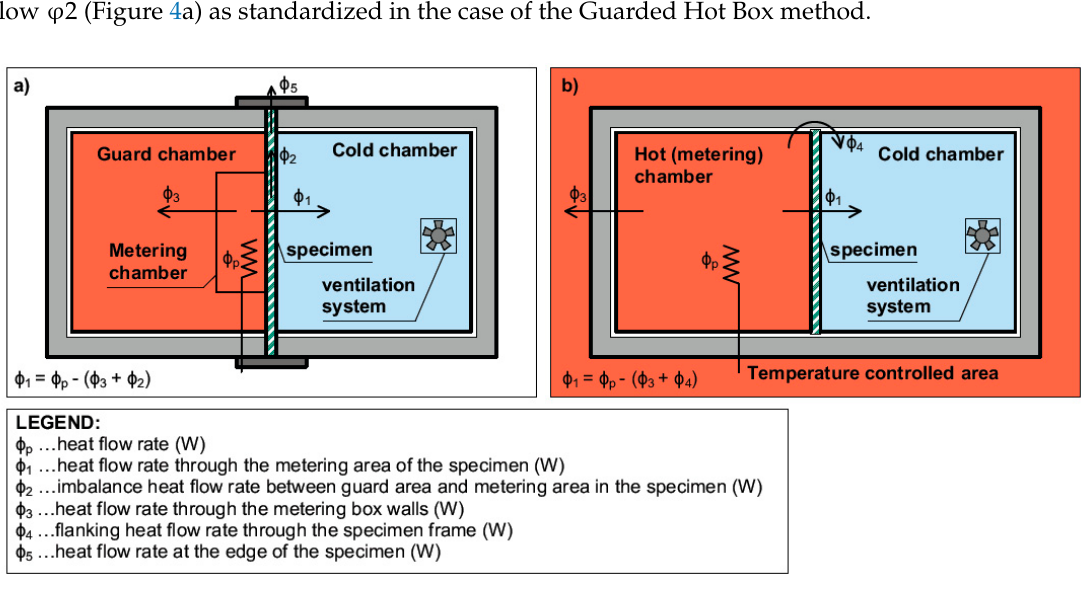
Figure 4. Scheme of the difference between ( a ) a Guarded Hot Box (according to EN ISO 8990 [32]) and the Modified Guarded Hot Box used in this study ( b ).